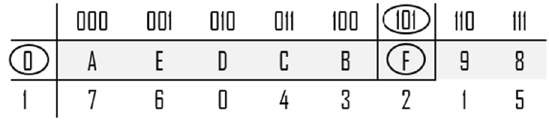
Fig. 9 S-Box with 4 bits input and 4 bits output